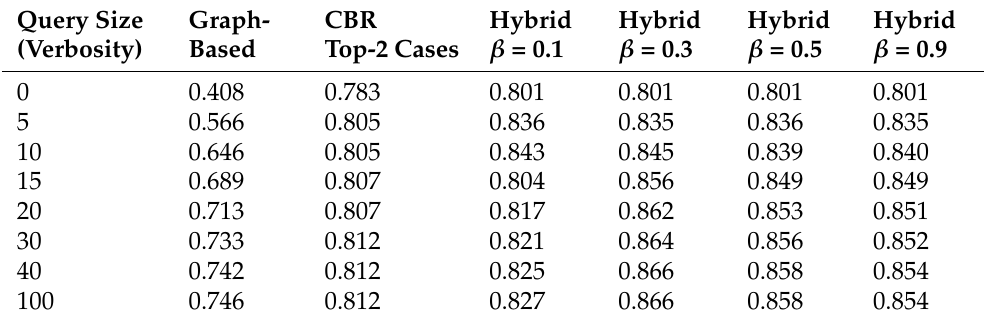
Table 3. Experiment 2: MAP values for individual recommendation techniques and hybrid